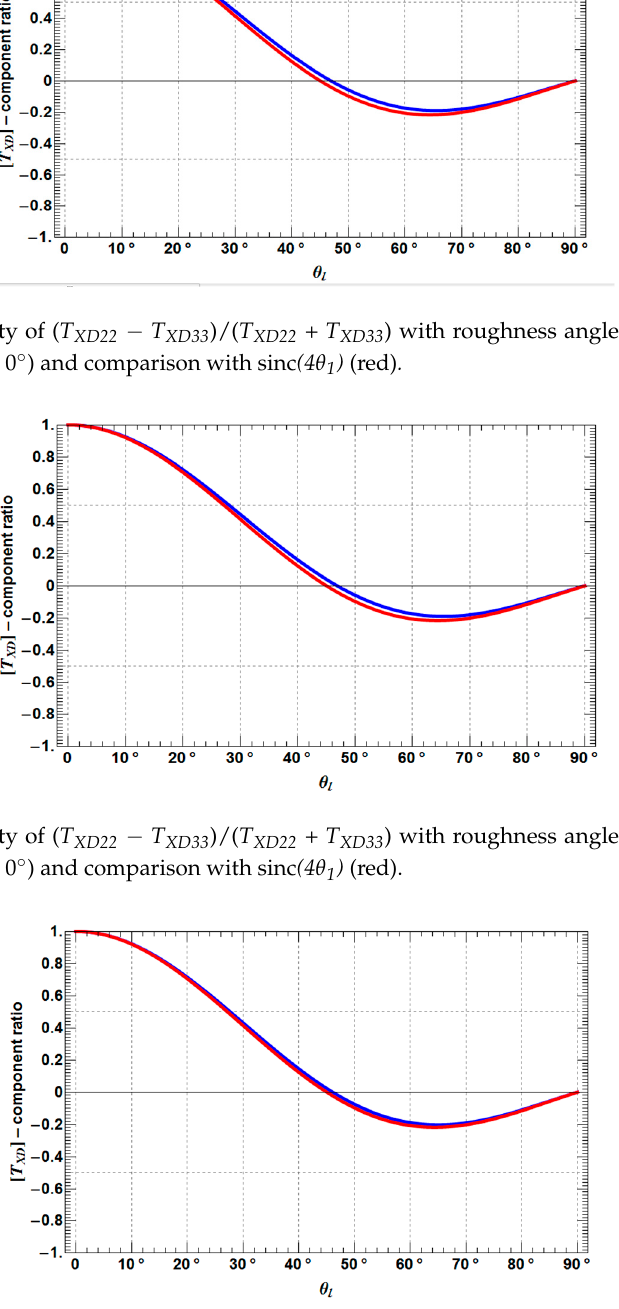
Figure 22. Sensitivity of ( T XD22 − T XD33 )/( T XD22 + T XD33 ) with roughness angle θ 1 (blue) ( ε s = 30, ε t = 30, ω l = 30°, ϕ = 0°) and comparison with sinc (4 θ 1 ) (red). Impact of Differential Phase ϕ and Scattering Loss L SXD on Coherency Matrix Combinations As seen in Equation (13), the differential phase ϕ between the two co-polarizations (HH, VV) accounts for the propagation phase difference occurring during the pass through the vegetation volume. Vegetation effects due to preferential orientations have an individual influence on the different polarizations. In Figures 23 and 24, the effect of an increased propagation difference affecting the two co-polarizations is shown for the two T-matrix combinations T XD22 + T XD33 and ( T XD22 − T XD33 )/( T XD22 + T XD33 ). The influence of ϕ on T XD22 + T XD33 for phase differences of up to 30° stays below 1 dB of change in power for all roughness levels (0 < ks < 1), which are conventionally occurring